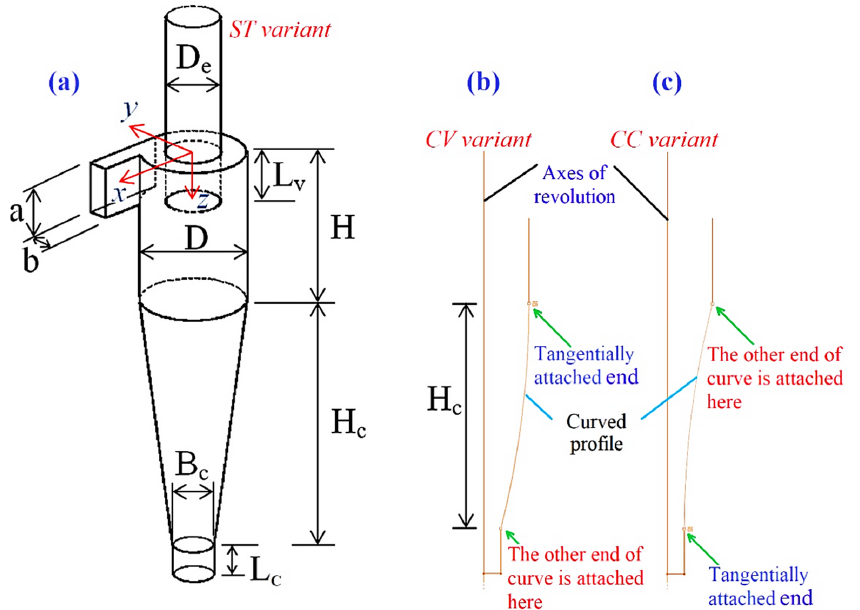
Figure 1. Geometrical details of the Stairmand high-efficiency cyclone model ( D = 0.205 m) with ( a ) straight walls of the conical section (referred to as the ST), ( b ) convex profile (referred to as the CV variant), and ( c ) concave profile (referred to as the CC variant).